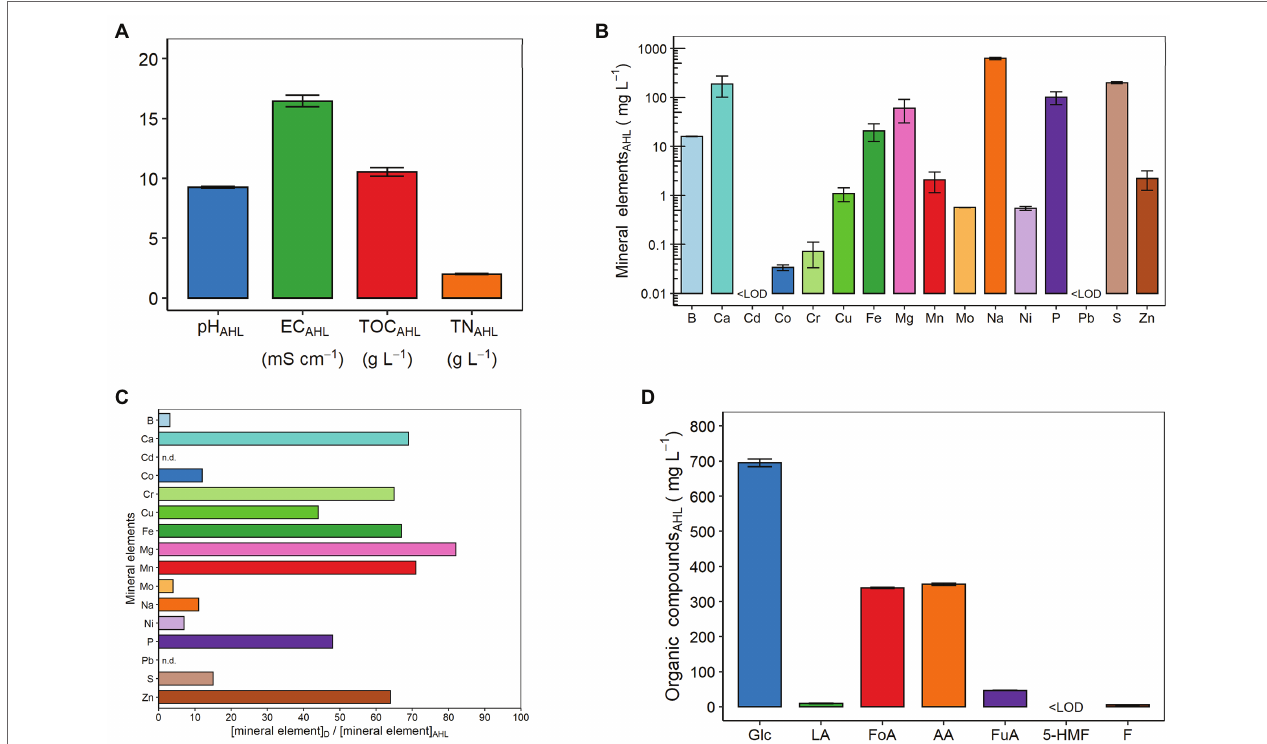
FIGURE 2 | Chemical properties of the aqueous liquid fraction of hydrothermal carbonization [aqueous HTC liquid (AHL)]: (A) pH, electrical conductivity (EC), total organic carbon (TOC), and total nitrogen (TN) content; (B) mineral element concentrations: boron (B), calcium (Ca), cadmium (Cd), cobalt (Co), chromium (Cr), copper (Cu), iron (Fe), magnesium (Mg), manganese (Mn), molybdenum (Mo), sodium (Na), nickel (Ni), phosphorus (P), lead (Pb), sulfur (S), and zinc (Zn); (C) ratio between the concentration in the digestate (D) and the concentration in the AHL of each of the following mineral elements: boron (B), calcium (Ca), cadmium (Cd), cobalt (Co), chromium (Cr), copper (Cu), iron (Fe), magnesium (Mg), manganese (Mn), molybdenum (Mo), sodium (Na), nickel (Ni), phosphorus (P), lead (Pb), sulfur (S), and zinc (Zn). For Cd and Pb, the ratio was not determinable (n.d.), as the mineral element concentration was below the LOD (i.e., 0.177 and 6.730 μ g L − 1 , respectively) in D and/or AHL; and (D) organic compound concentrations: glucose (Glc), lactic acid (LA), formic acid (FoA), acetic acid (AA), fumaric acid (FuA), 5-hydroxymethylfurfural (5-HMF), and furfural (F). LOD, limit of detection. The LODs of Cd and Pb by inductively coupled plasma-optical emission spectroscopy (ICP-OES) were 0.177 and 6.730 μ g L − 1 , respectively. The LOD of 5-HMF was 0.706 mg L − 1 and was determined using the method described by Miller and Miller (2010). Data are presented as means ± SE ( n = 3). Data of mineral element concentrations are presented on a logarithmic scale (Log 10 ) for better graphical display, and the values are detailed in Supplementary Table 2